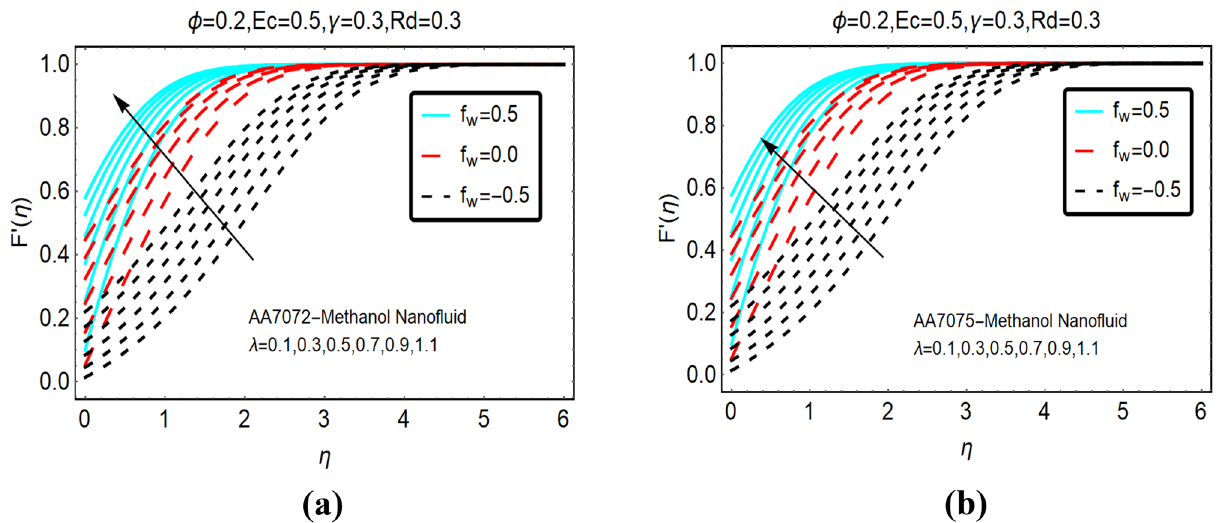
Figure 2. The effects of velocity slip on F ′ ( η ) ( a ) AA7072-Methanol ( b ) AA7075-Methanol.